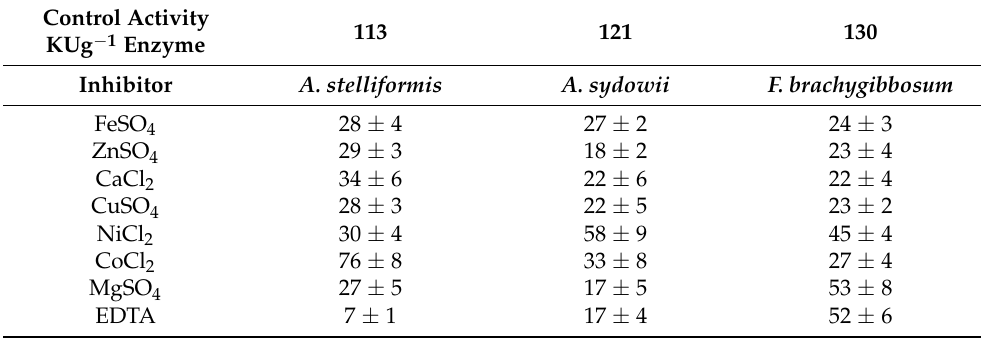
Table 2. Effect of metal ions and EDTA (5 mmol mL − 1 ) on keratinase activity produced by different fungi (mean ± SD, n = 3). The results are expressed as the proportion of the activity in the tested inhibitory conditions, from the keratinase activity in the control without inhibitors. Control Activity KUg − 1 Enzyme